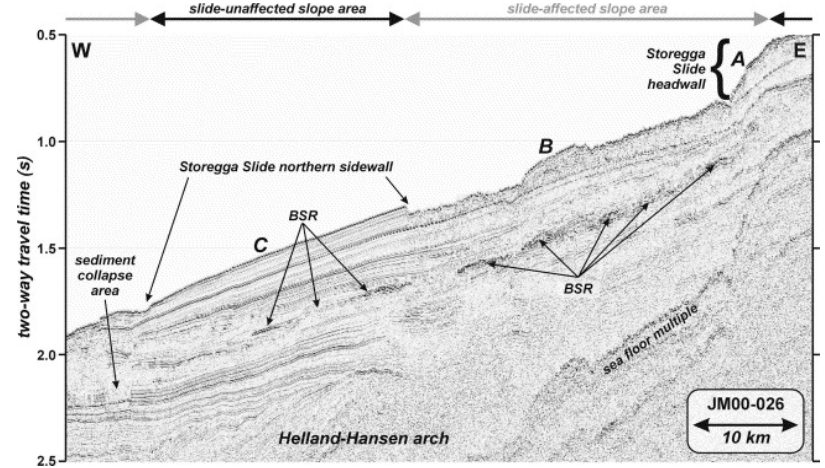
Figure 1. High-resolution seismic reflection profile of Storegga Slide [26].